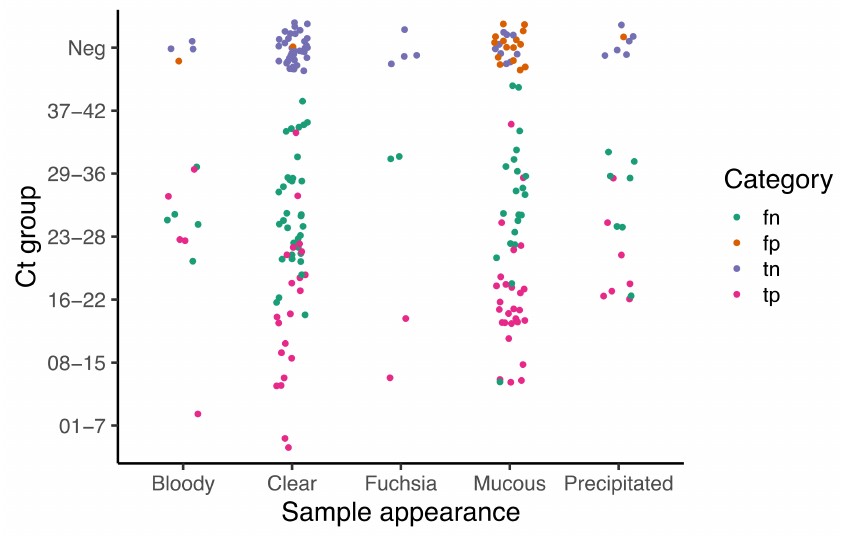
Figure 2. Effect of sample quality on visual detection. Categories correspond to: tp = true positives, tn = true negatives, fp = false positives, qRT-PCR negatives that turned yellow in LAMP, fn = false negatives, qRT-PCR positives that gave faint or negative visual outcomes. Percentage of agreement with qRT-PCR is 57.1, 62.4, 75.0, 50.0 and 62.0, for bloody, clear, fuchsia, mucus and precipitated conditions, respectively.